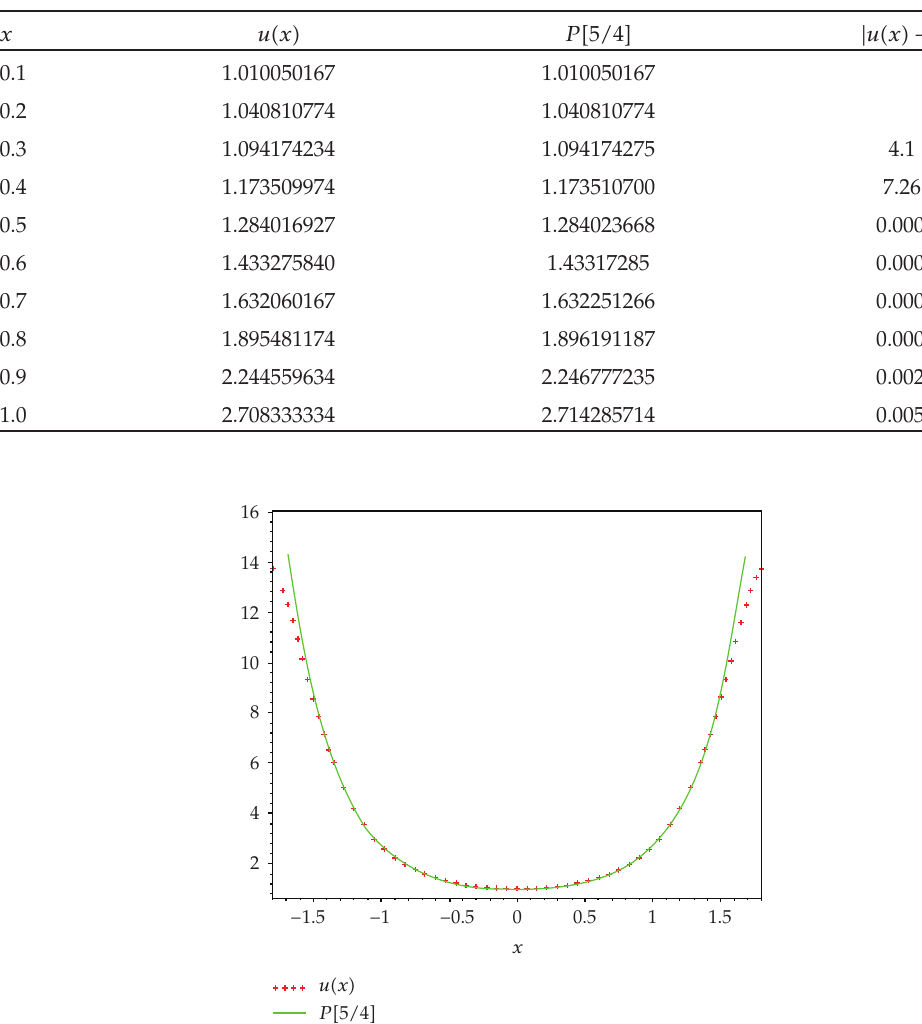
Table 2: Numerical solution of u (cid:7) x (cid:8) .